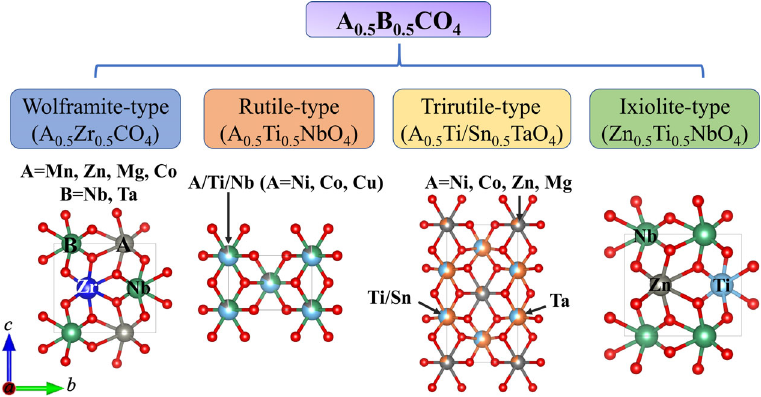
Fig. 5 Schematic of classification of A 0.5 B 0.5 CO 4